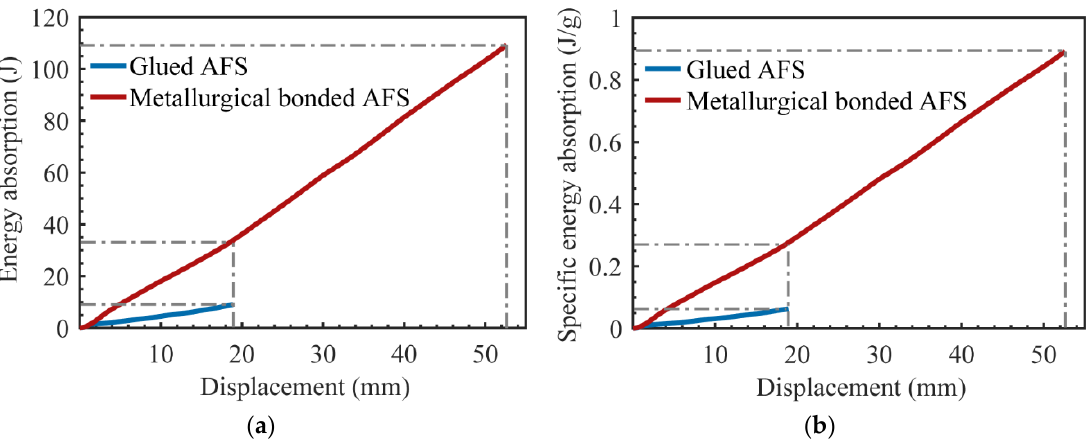
Figure 17. Energy absorption ( a ) and the specific energy absorption ( b ) of AFS.